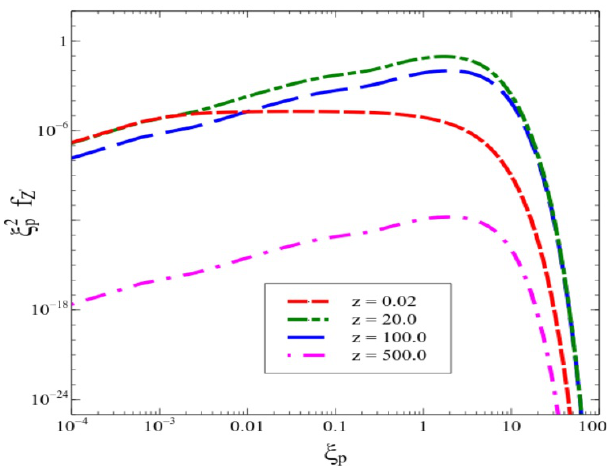
Figure 1 . Z 0 distribution function versus the dimensionless parameter (cid:24) p . Here, the relevant BLSMIS parameters are (cid:12)xed as follows: g 0 = 12 : 5 (cid:2) 10 (cid:0) 10 , M Z 0 = 10 GeV, M h 10 keV, and (cid:11) = 0 : 01